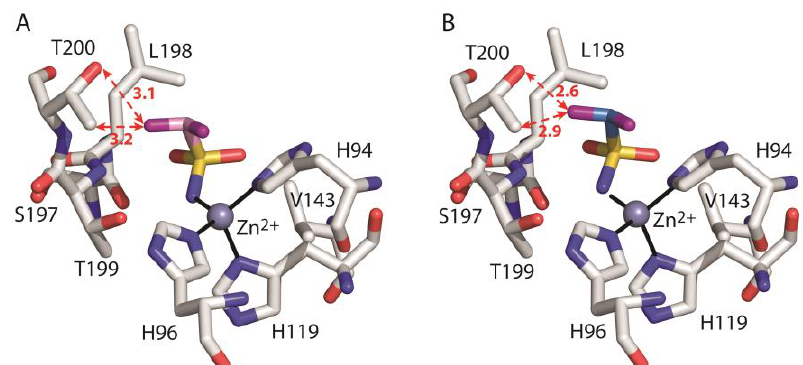
Figure 6. Detail of the active site in the model systems hCA II/ 2 ZBG ( A ) and hCA II/ 2* ZBG ( B ). The ligand, the zinc ion with the three coordinating histidines and enzyme residues which give a major contribution to ligand binding are shown. The hydrogen atoms have been omitted for clarity. The distances (in Angstroms) between one of the ligand fluorine atoms and T200 O γ and C γ atoms are indicated with red dotted arrows. Table 3. Per-residue decomposition of the binding free energy (kcal/mol) computed by the MM/GBSA method for the crystallographic adduct hCA II/ 2 and the model adduct hCA II/ 2* ring . Details of ∆ G ∆ G bind -Phe131 and bind -Pro202 energy terms (kcal/mol) are shown in light grey lines. hCA II/2 ∆ G bind -Ile91